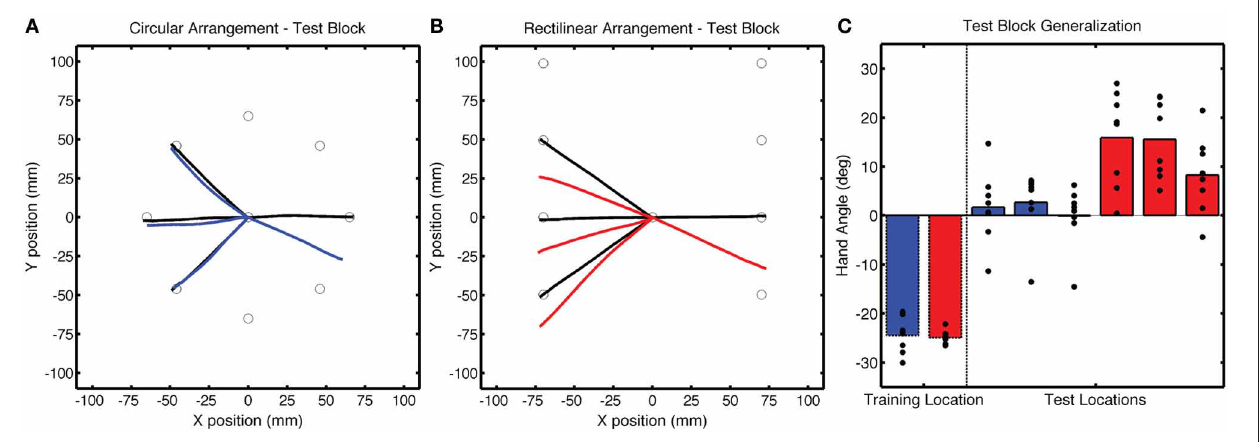
FIGURE 4 | Group averaged trajectories during the Test block in Experiment 1 for the (A) CircleRotation group (blue) and (B) LineTranslation group (red) compared with the averaged trajectories